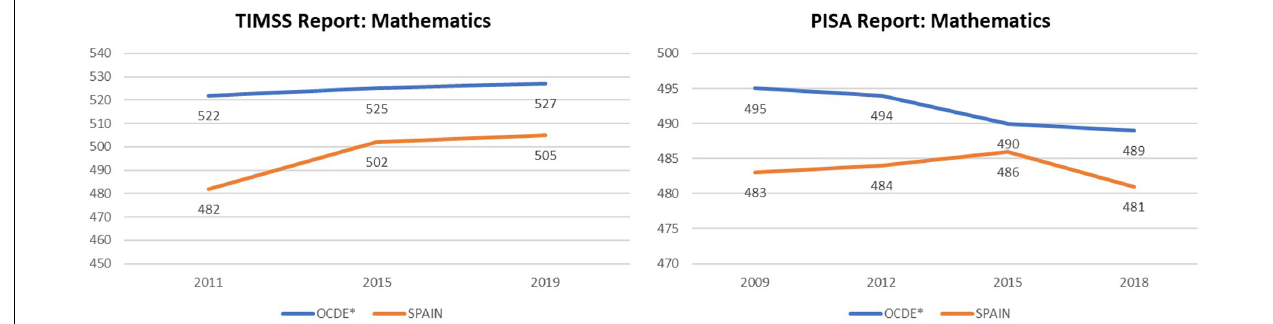
FIGURE 1 | Progress of the mean scores in mathematics from Trends in International Mathematics and Science Study report (TIMSS) and Program for international student assessment report (PISA). *OECD, Organisation for Economic Cooperation and Development.